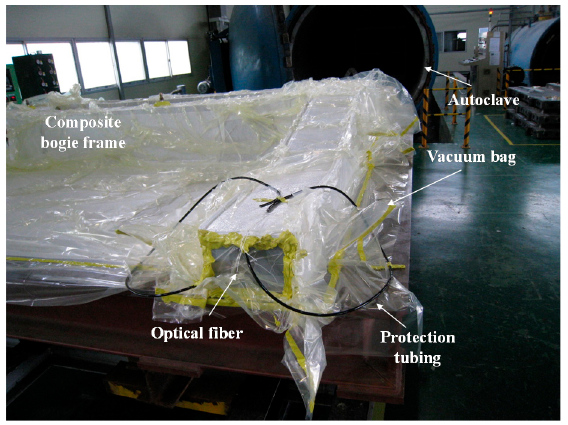
Figure 5. Composite bogie frame with embedded optical fiber before autoclave molding.